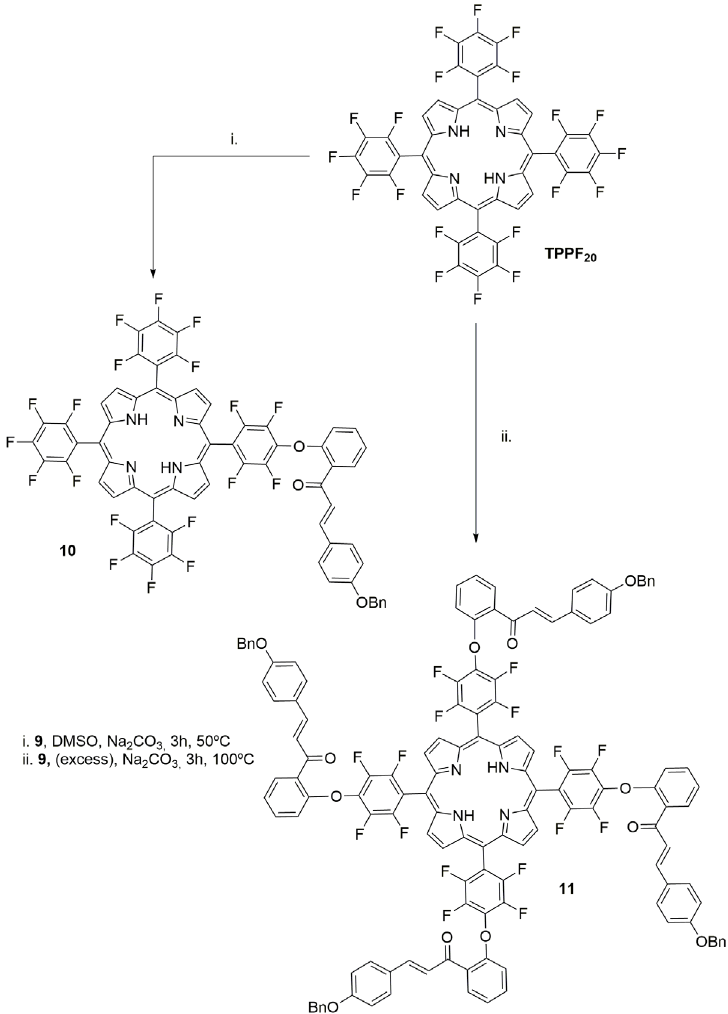
Figure 15 - Synthesis of chalcone-porphyrin derivatives 10 and